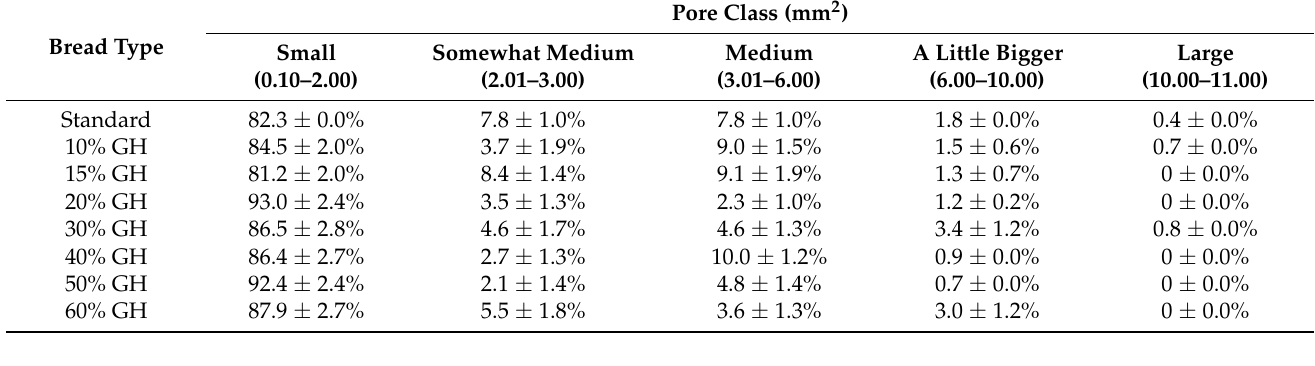
Table 2. Pore analysis of standard bread versus the GH bread.